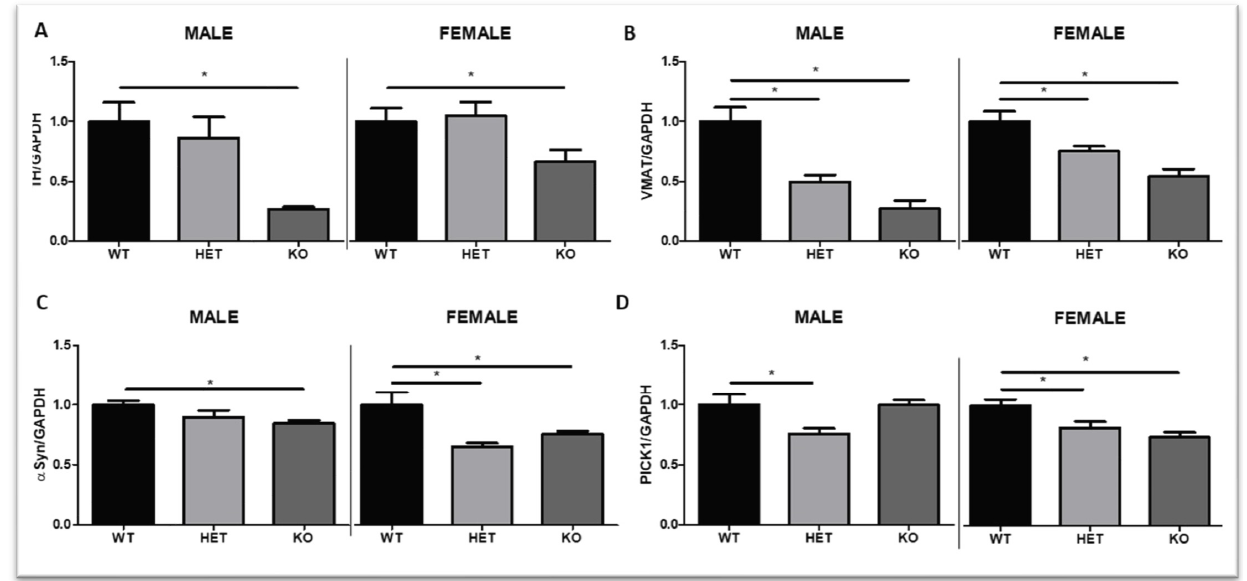
Figure 7. Striatal protein expression levels of ( A ) Tyrosine-hydroxylase (TH), ( B ) Vesicular monoamine transporter 2 (VMAT2), ( C ) α -Synuclein ( α -Syn) and ( D ) protein interacting with C-kinase-1 (PICK) in DAT mutant rats, at PND42. Quantitative analysis. * p < 0.05 compared to WT rats. Mean ± SEM. N = 4–5 per group.